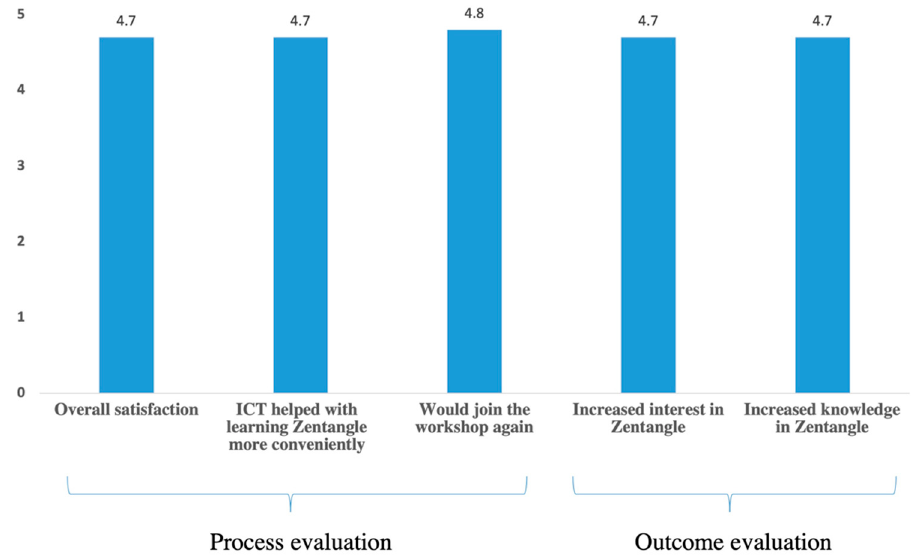
Figure 2. Overall satisfaction and perceived changes in knowledge and attitudes of Caritas Aberdeen IFSC’s online Zentangle workshops (Phase 2, n = 294).